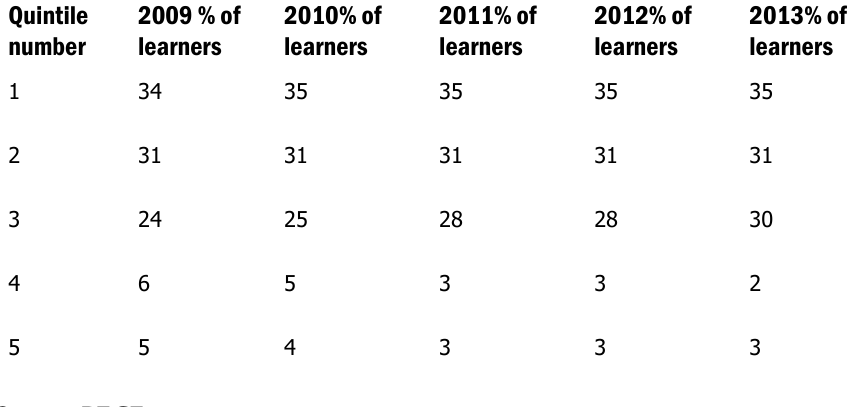
Table 2: Percentage Eastern Cape learners in schools per quintile in 2009-2013 Quintile